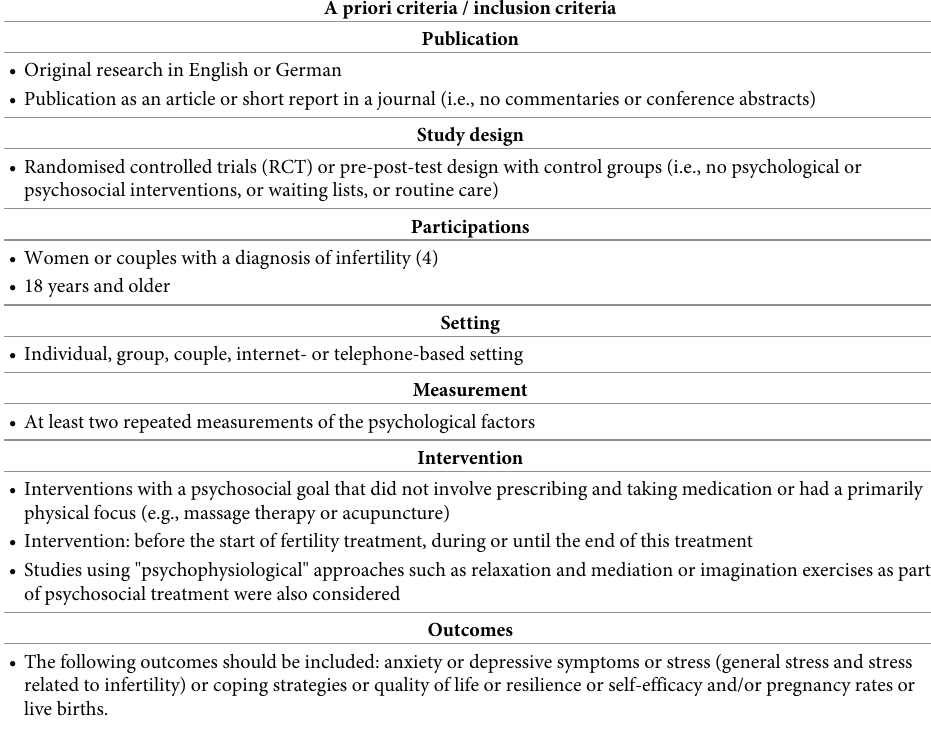
Table 1. Inclusion criteria for the selection of